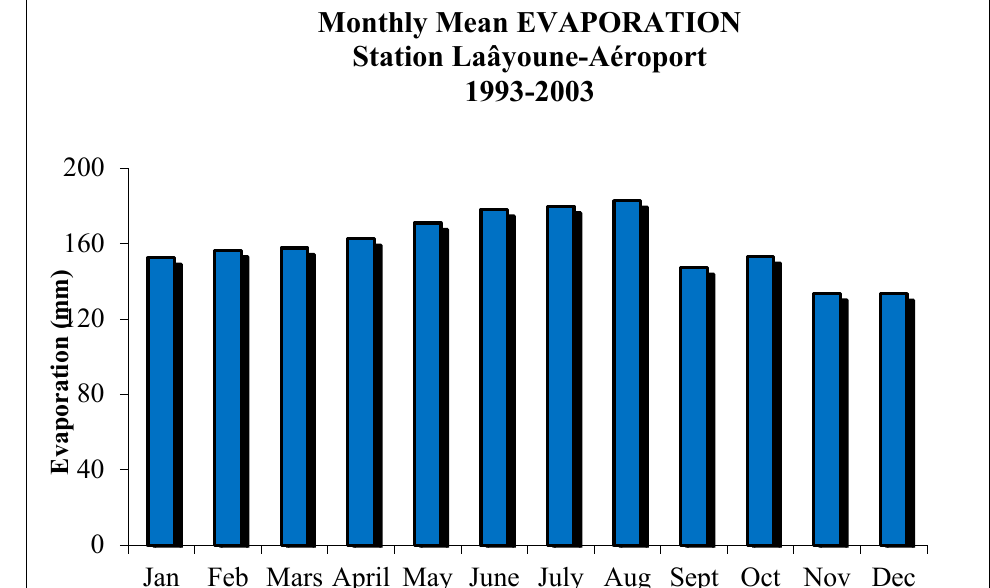
Figure 8. Monthly mean evaporation recorded for 1993 to 2002.